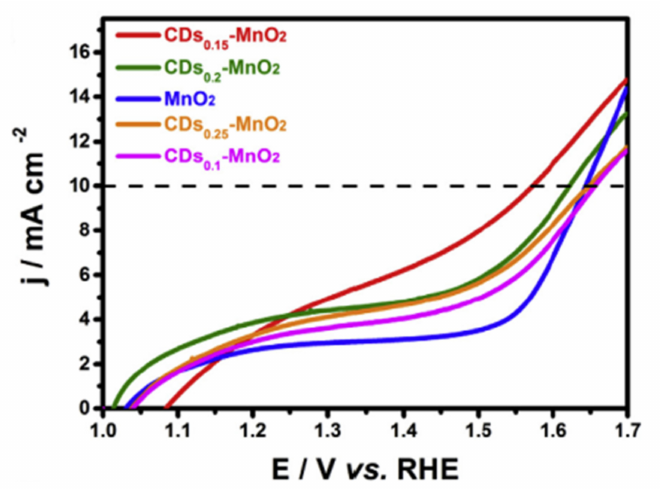
Figure 6. LSV for OER of carbon-quantum-dots-embedded δ -MnO 2 in 1M KOH electrolyte. Repro- duced with permission from [53]. Copyright 2019